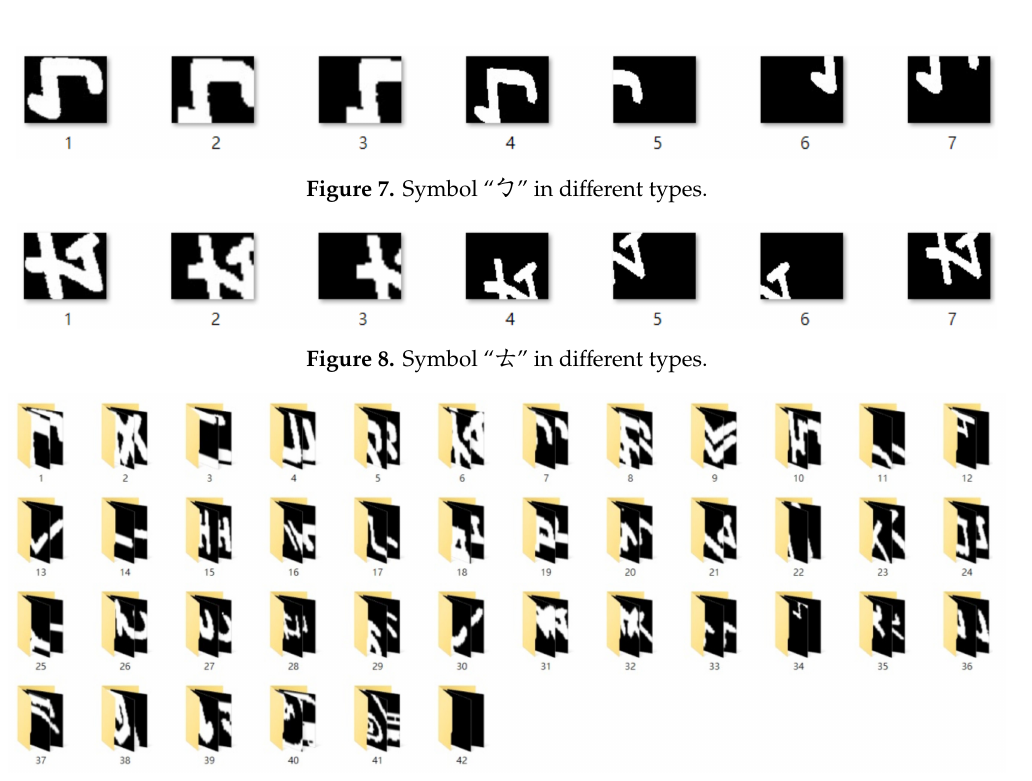
Figure 9. Database of symbols.